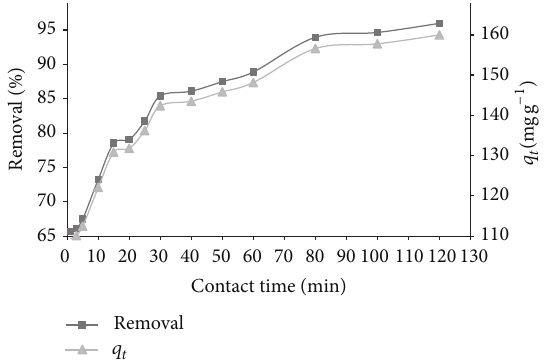
Figure6:Effectofparticlesizes(pH = 4 ,adsorbentdose = 0.3 gL −1 , = 50 mgL −1 , 𝑡 = 80 min, A . S . = 170 rpm, 𝑇 = 298 𝐶 𝑜